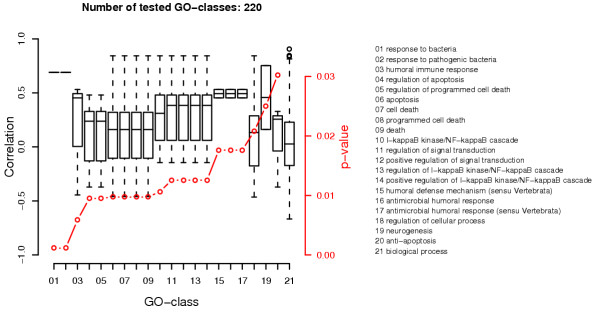
Correlations and p-values of the expression dataset from Pathan. Analogous to figure 3